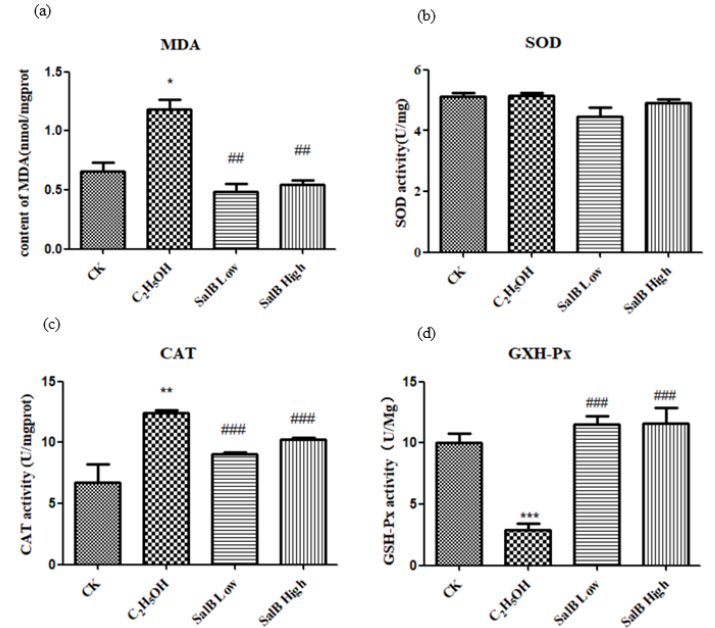
Figure 8. Salvianolic acid can inhibit oxidative stress caused by ethanol. ( a ) The content changes of MDA increased after adding ethanol; ( b ) SOD activity did not change; ( c ) CAT activity increased; ( d ) GXH-Px activity decreased. The statistical results shown represent the means ( n = 3); vs. the control group ( n = 3) * p < 0.05, ** p < 0.01. vs. the ethanol-treated group # p < 0.05, ## p < 0.01, ### p < 0.001.